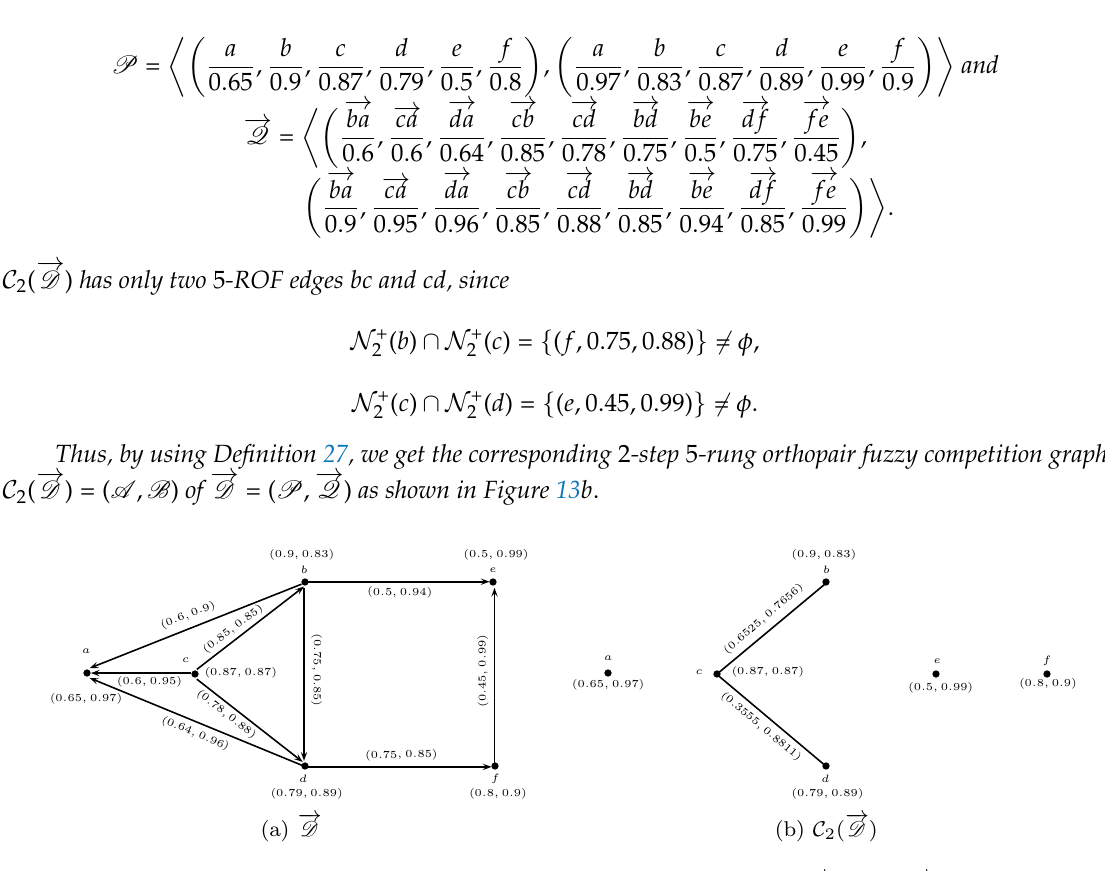
Figure 13. m -Step q -rung orthopair fuzzy competition graph. ( a ) −→ D ; ( b )